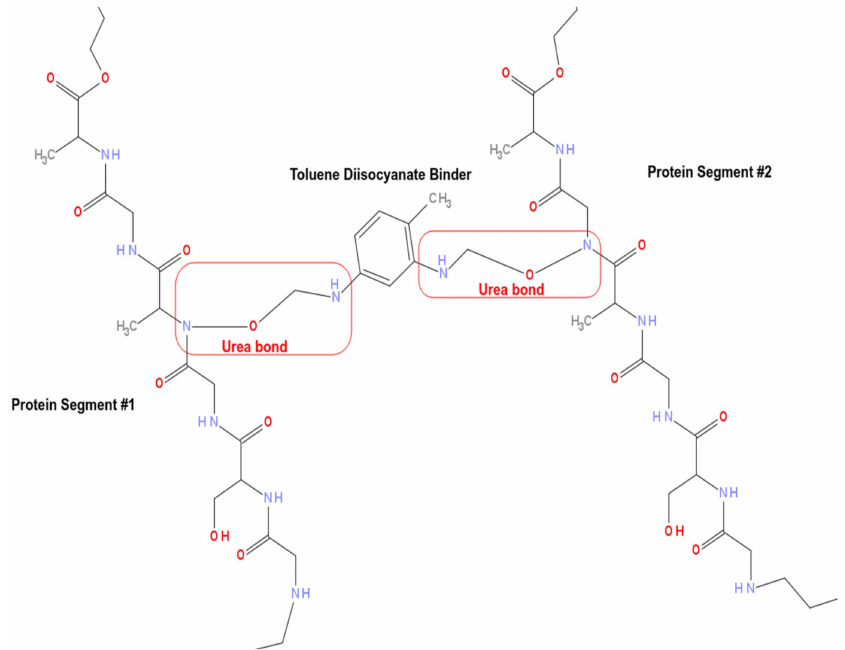
Figure 1. Two protein segments. Each one of the protein segments is composed of -Gly-Ser-Gly-Ala- Gly-Ala- fragments and between these two fragments, there is a TDI binder connecting the protein fragments through two ureic